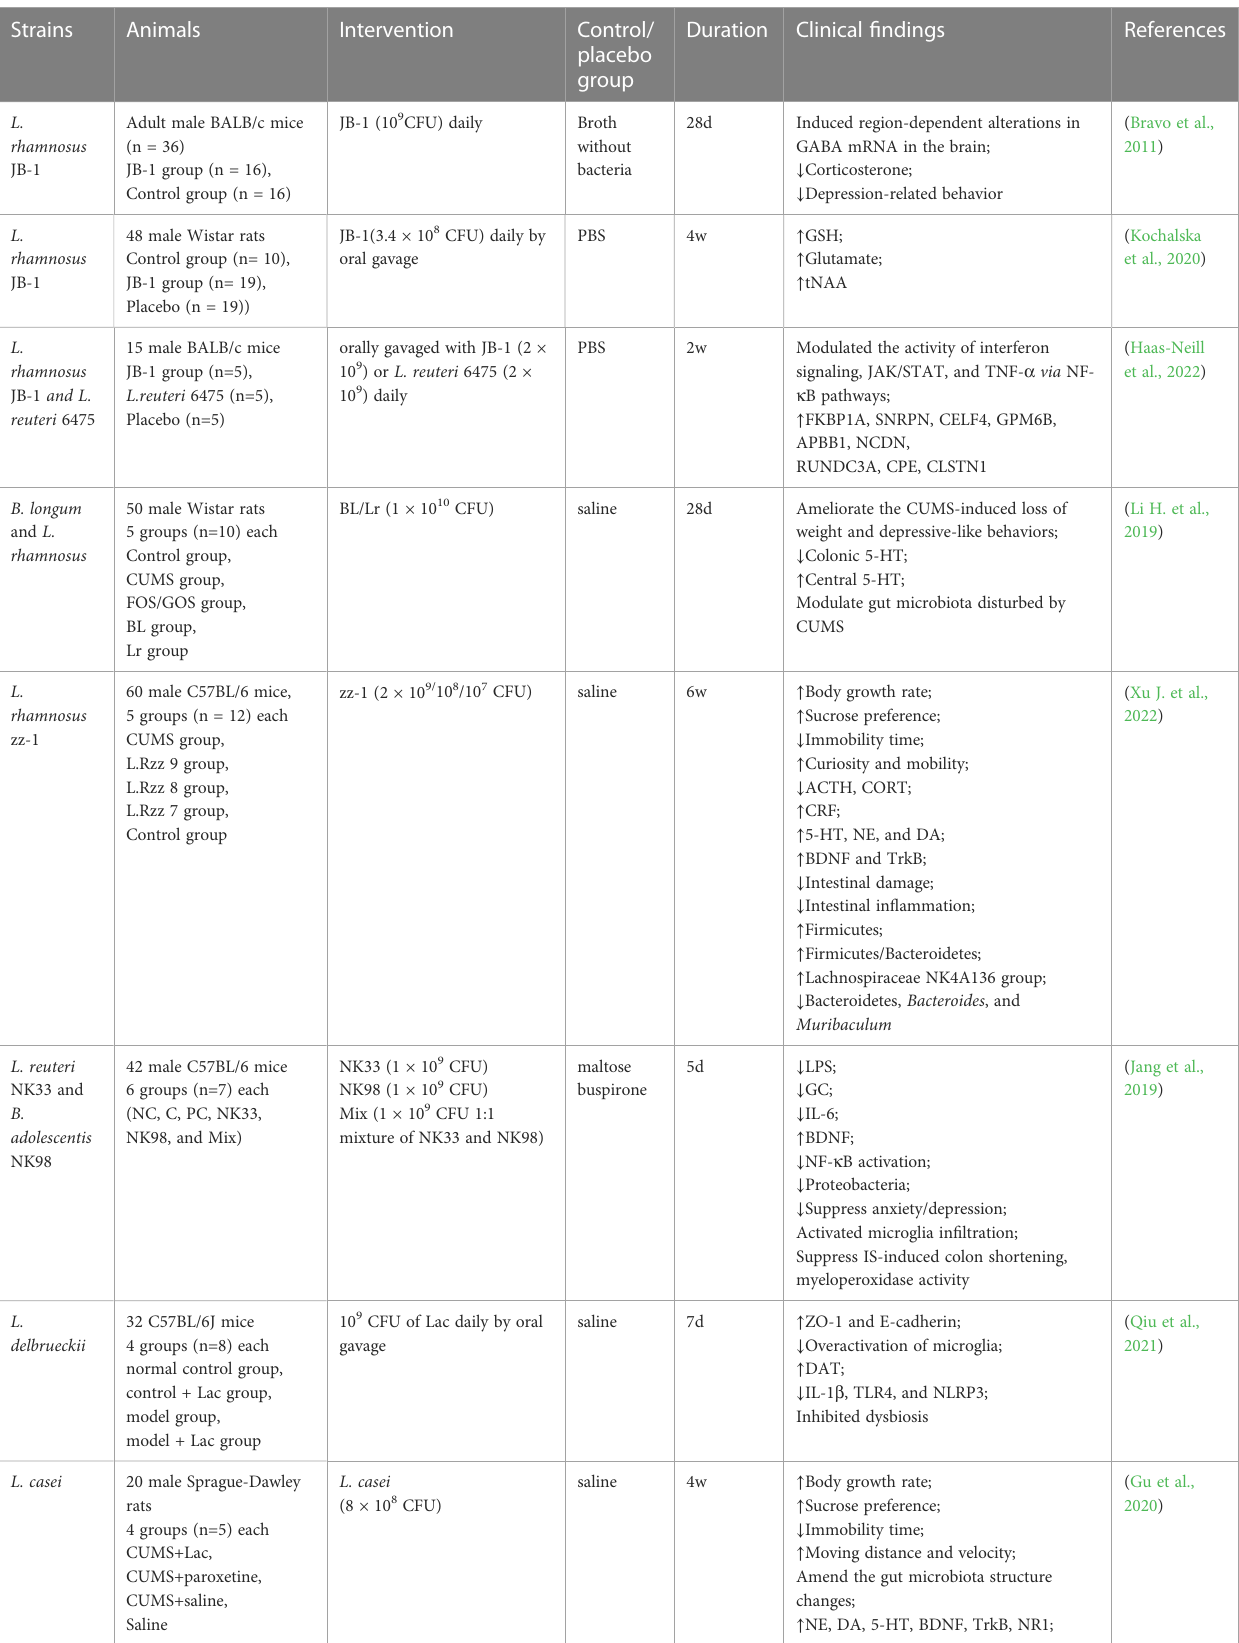
TABLE 2 Animal studies of probiotics on depression and its comorbidities. Strains